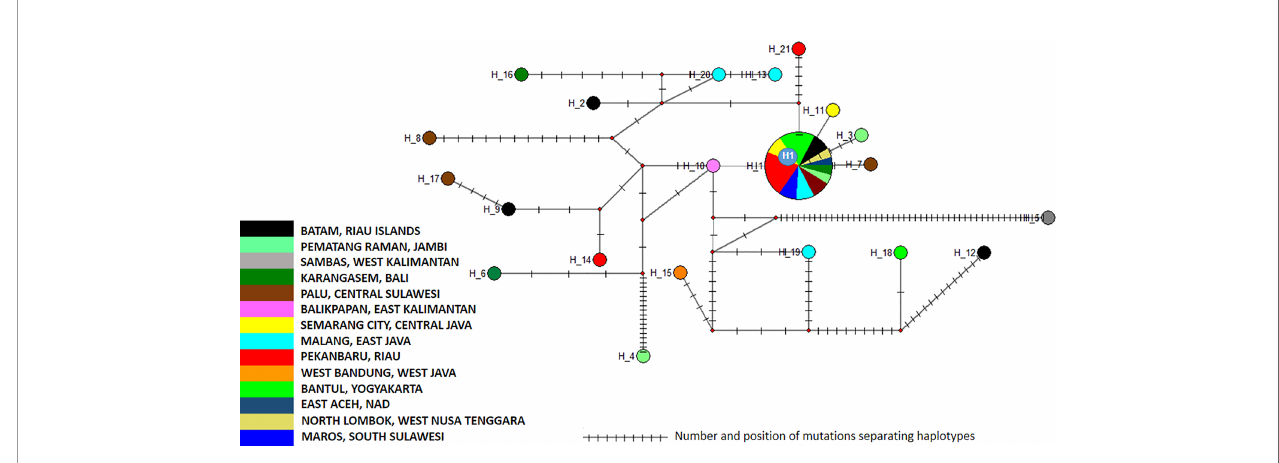
FIGURE 4 | Network of Aedes aegypti ITS2 sequences. The fi gure represents the frequency of each haplotype of the ITS2 sequence of Ae. aegypti in the regions sampled. The network represents the number of mutations between the haplotypes and their